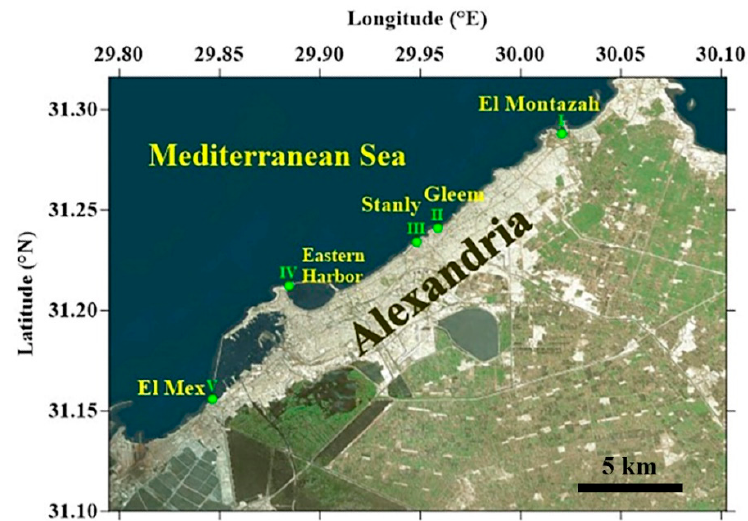
Figure 1. The sampling sites are along the Alexandria coast. El Mex (MX); Eastern Harbor ‐ (EH); Gleem (GL); Stanly (ST); El Montazah (EM). Gleem (GL); Stanly (ST); El Montazah